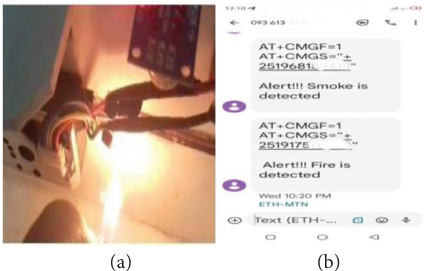
Figure 12: (a) Fire and smoke sensor testing; (b) SMS notifcation of fre and smoke.